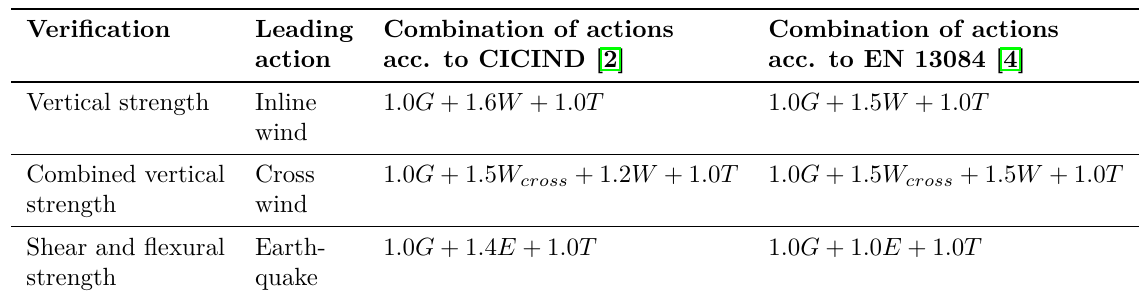
Table 1. Combination of actions at ULS for chimneys acc. to [6].